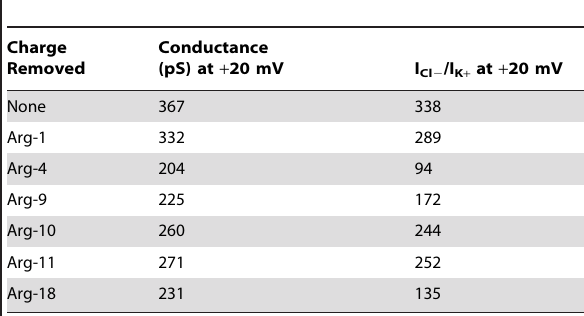
Table 4. Effects of turning off charges at various arginine